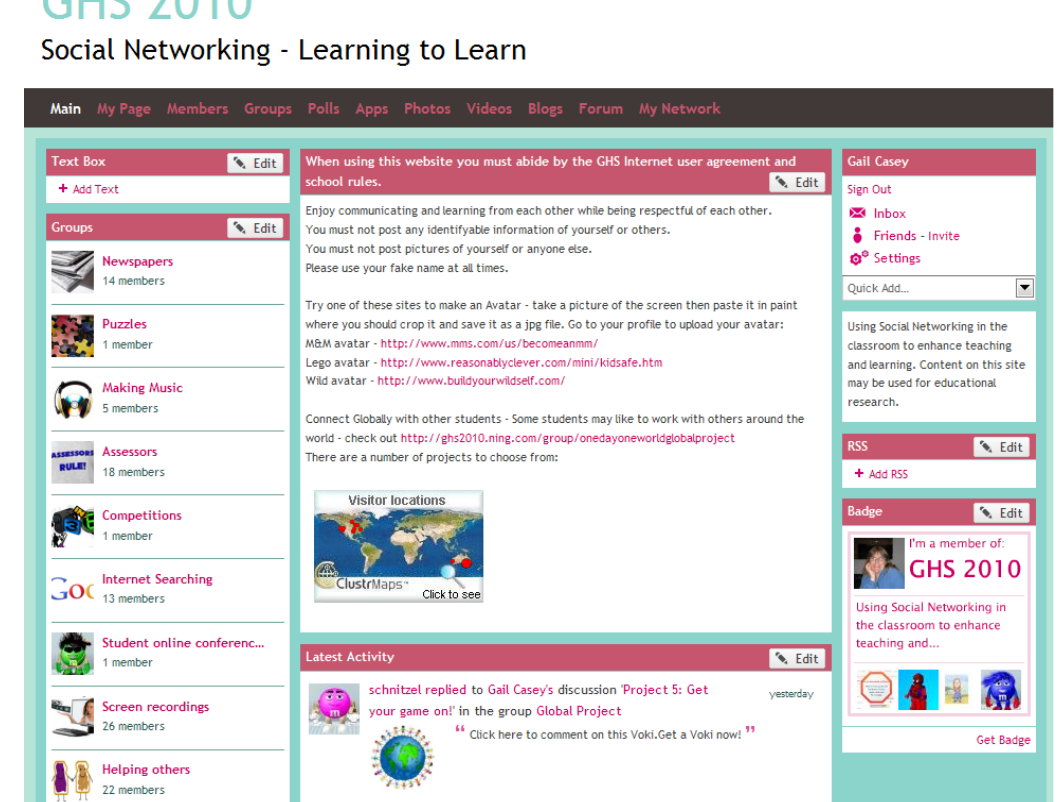
Figure 2. Screen clip of the Ning social networking site with 159 members from the teacher’s